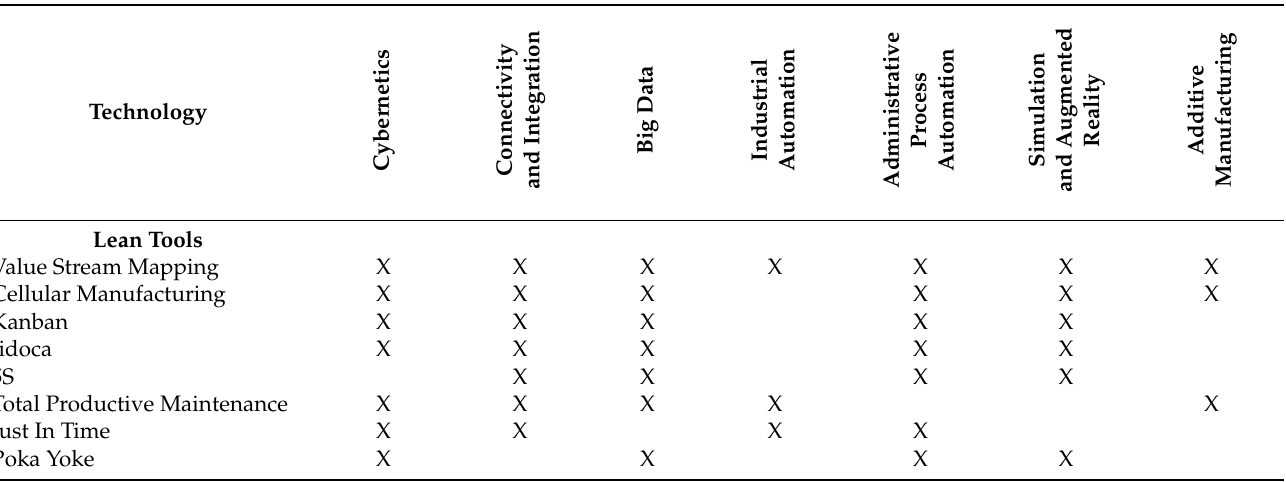
Table 4. Analysis of the article “Implementation of Industry 4.0 Techniques in Lean Production Technology: A Literature Review”